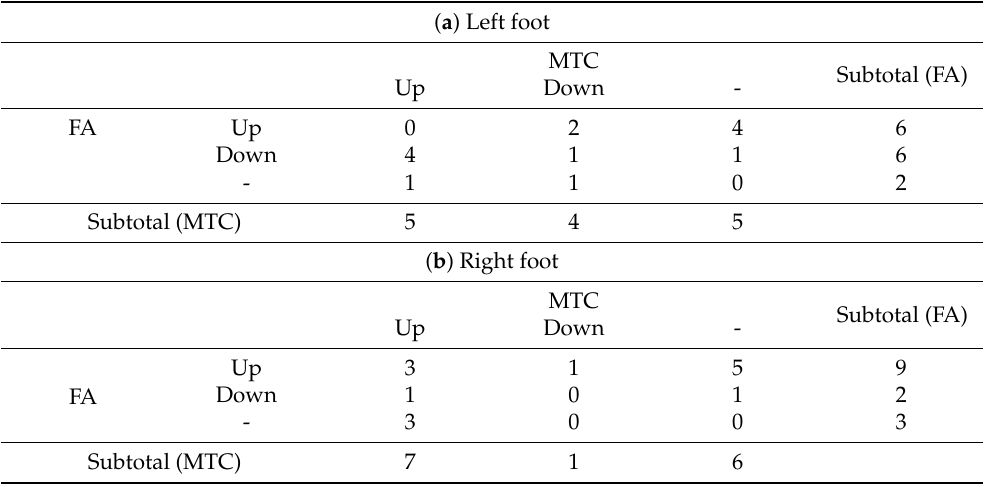
Table 3. Number of participants with a significant increase or decrease in the FA or MTC owing to fatigue (Up indicates a significant increase; Down indicates a significant